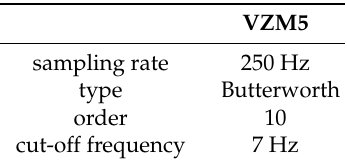
Table 10. Filter settings.